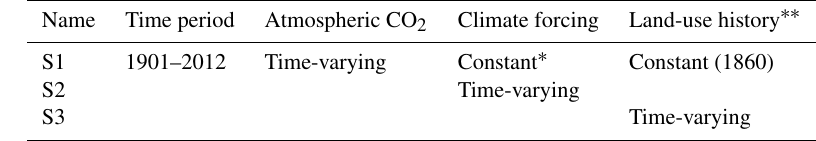
Table 2. Experimental design of TRENDY simulations.